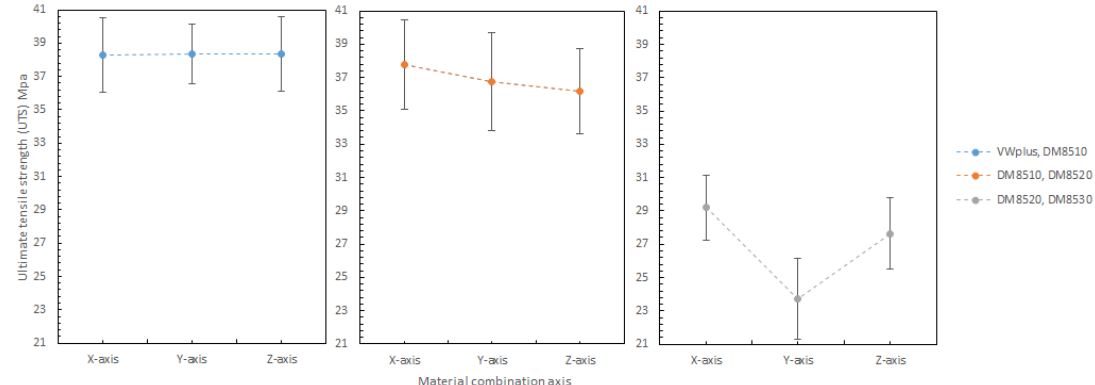
Figure 30. Combination axis effect on ultimate tensile strength (UTS) at 25 degree Celsius.